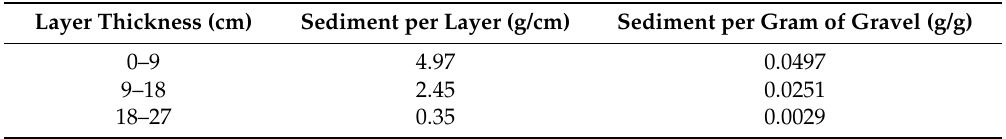
Table 3. Characteristics of sediment trapped in gravel layer after Run 1 of the long-term flow clogging experiment.